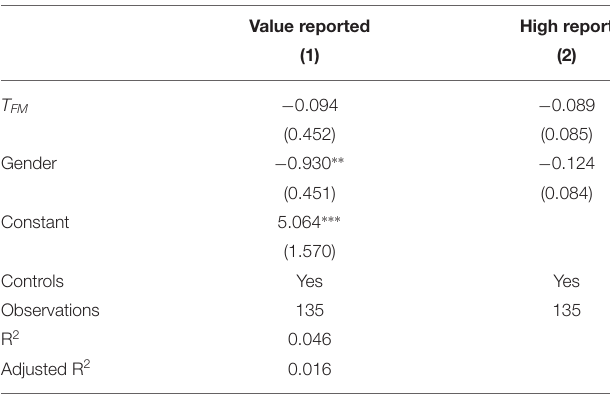
TABLE 2 | Results of OLS and probit